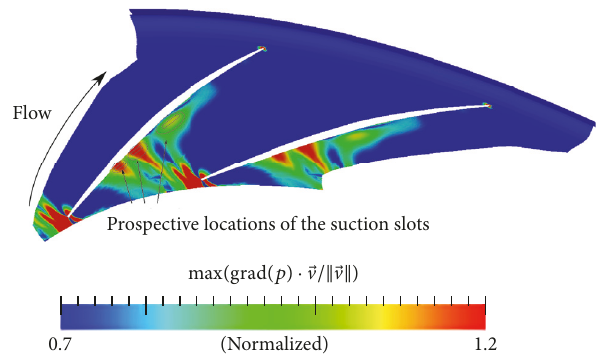
Figure 1: Maxima of instantaneous adverse pressure gradient, with- out control. Prospective locations of the suction